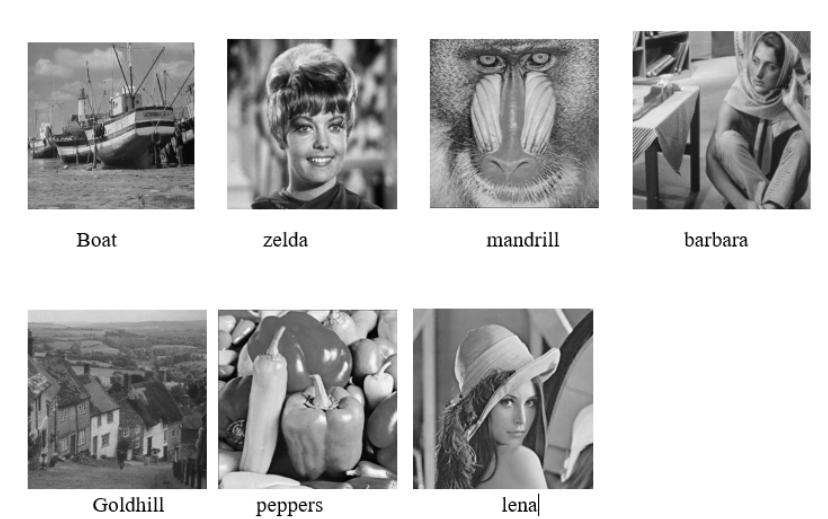
Figure 8: Samples